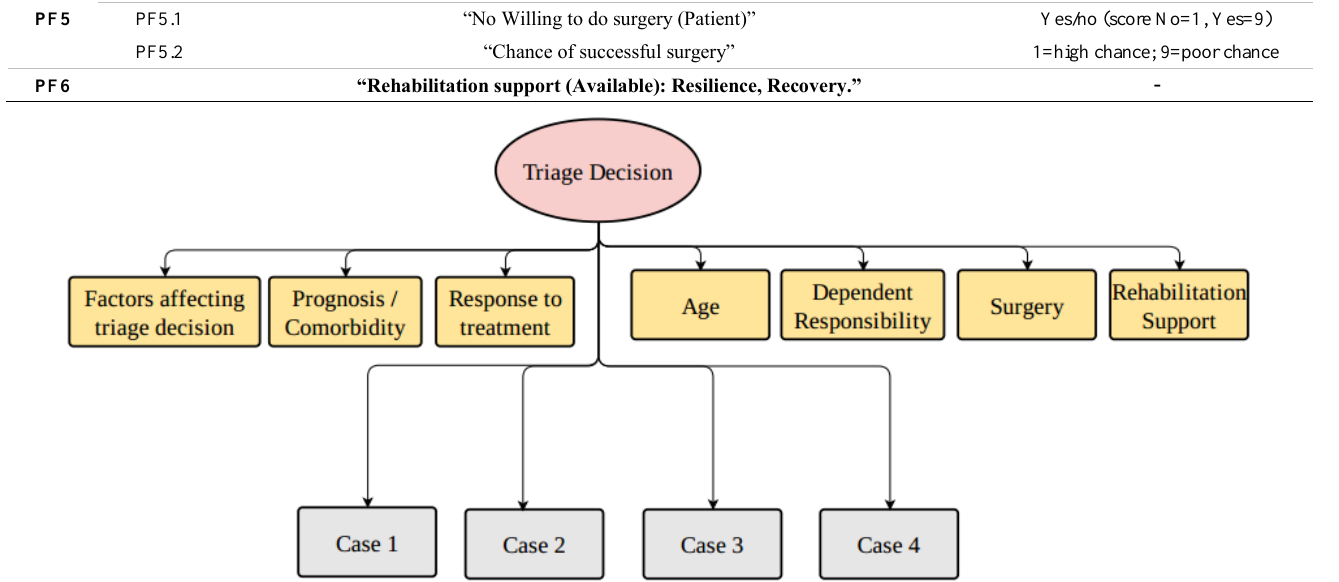
Figure 1. Hypothesized Decision-Making Research